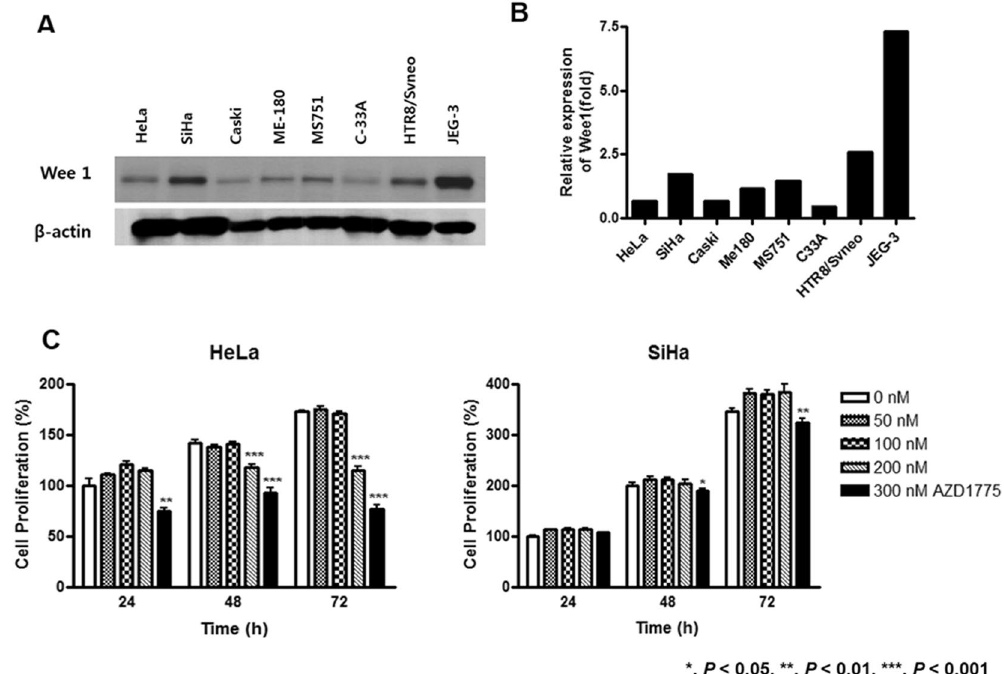
Figure 1. Wee1 expression in cervical cancer cell lines and cytotoxic effects of AZD1775 in HeLa and SiHa cells. Cervical cancer cell lines showed lower intensities of Wee1 expression compared to trophoblastic cell